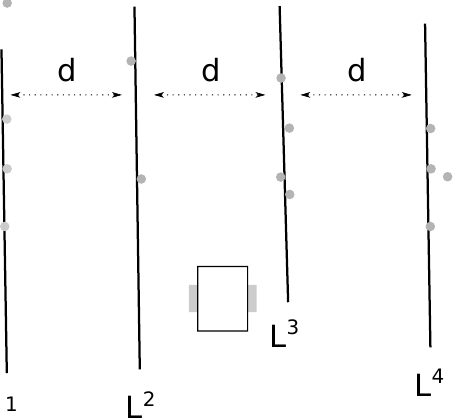
Figure 8. The filtered models L n , with n = 4, resulting in the configuration depicted in Figure 7. The models L 2 and L 4 are computed according to L 0 , L 1 , and d